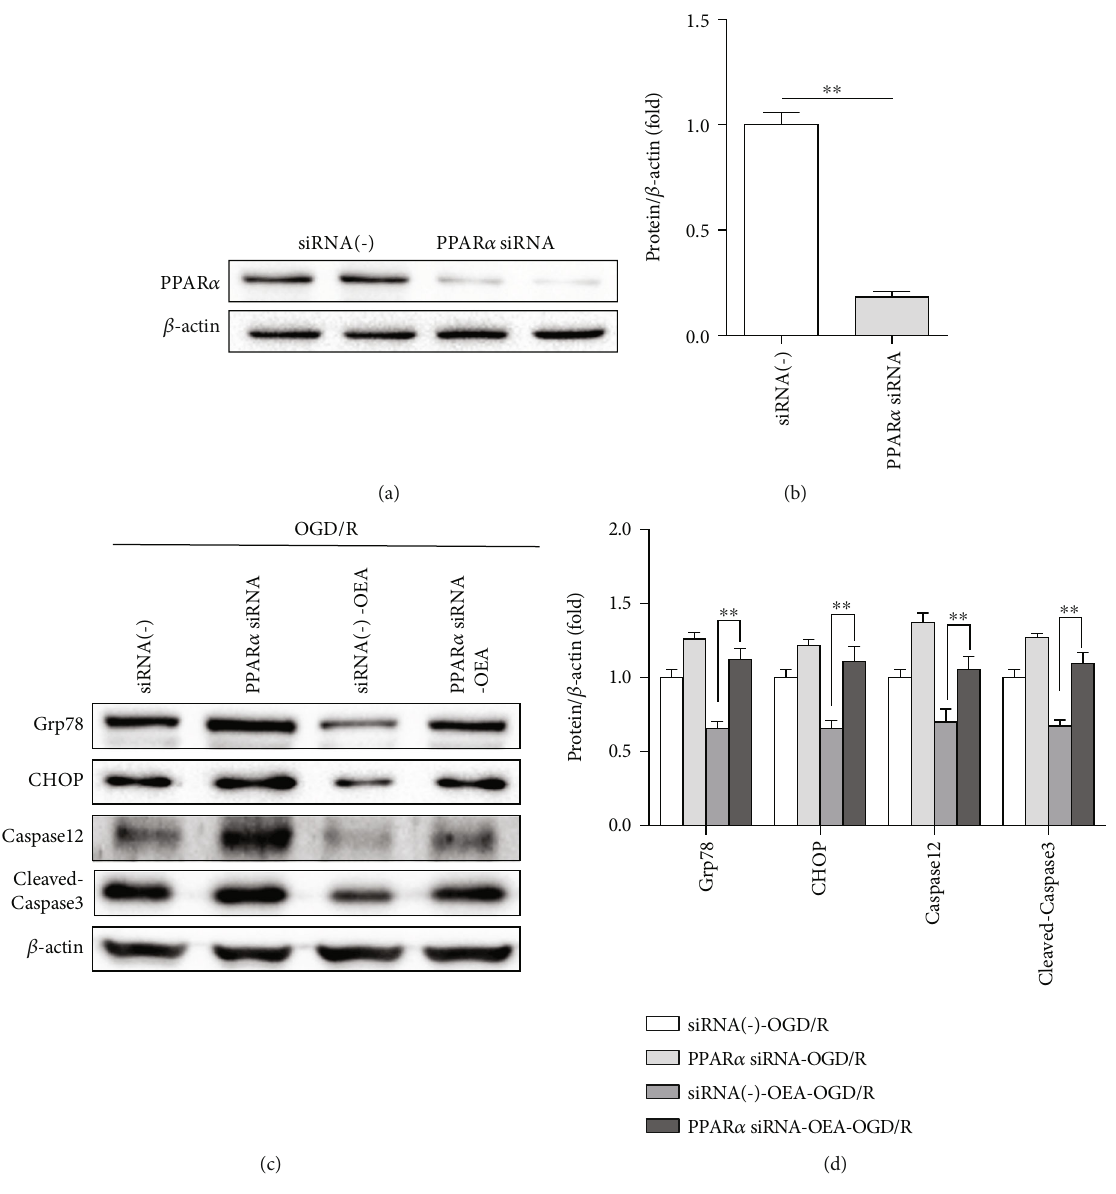
Figure 6: Knockdown of PPAR α exacerbates ER stress-associated apoptosis and reverses the protect e ff ect of OEA in HepG2 cells. (a and b) PPAR α protein expression after transfected siRNA(-) or PPAR α siRNA. (c and d) The expression level of Grp78, CHOP, Caspase12, and cleaved-Caspase3 was measured by western blotting in HepG2 cells transfected with PPAR α and then treated with OEA. ∗∗ p < 0 : 01 and ∗ p < 0 : 05